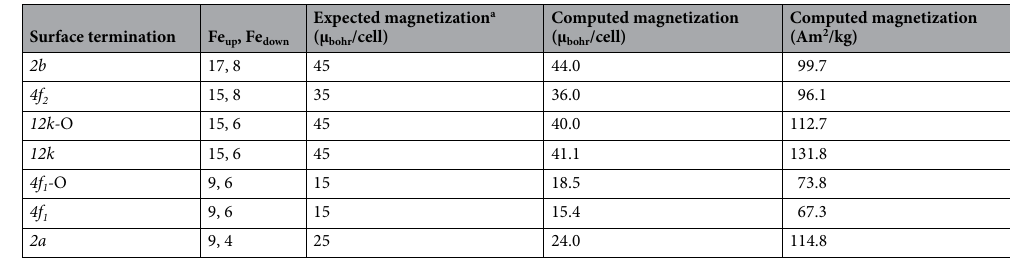
Table 2. Magnetic properties of the considered BHF bulk terminations are represented in Fig. 7b. The expected magnetization is simply estimated from the difference between the number of Fe up and Fe down ions, assuming a 3 + oxidation state. These values are compared to the computed magnetization. a Note that the expected magnetization should not be mistaken with the predicted Ms values from Table